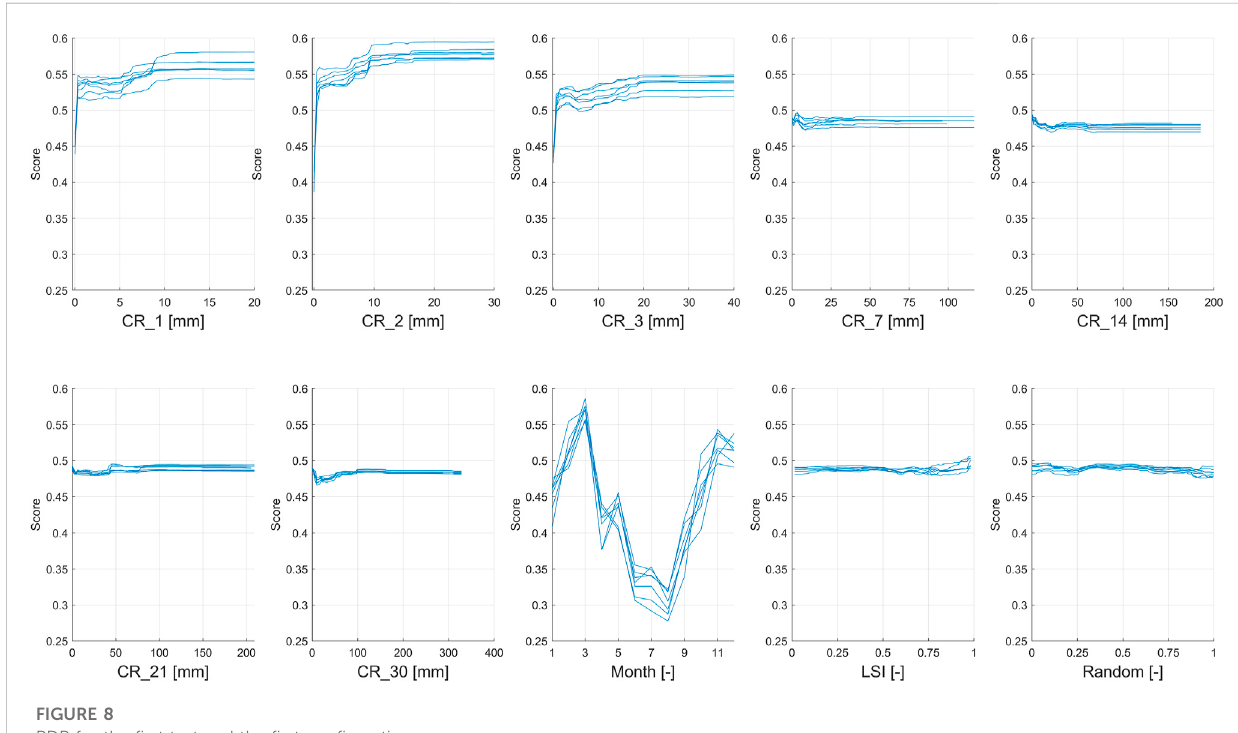
FIGURE 8 PDP for the fi rst test and the fi rst con fi guration.